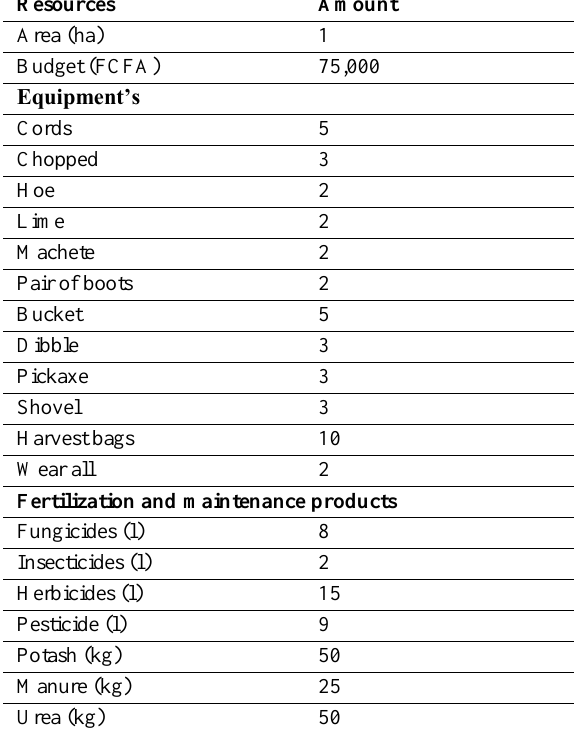
Table 14. Available resources in Scenario